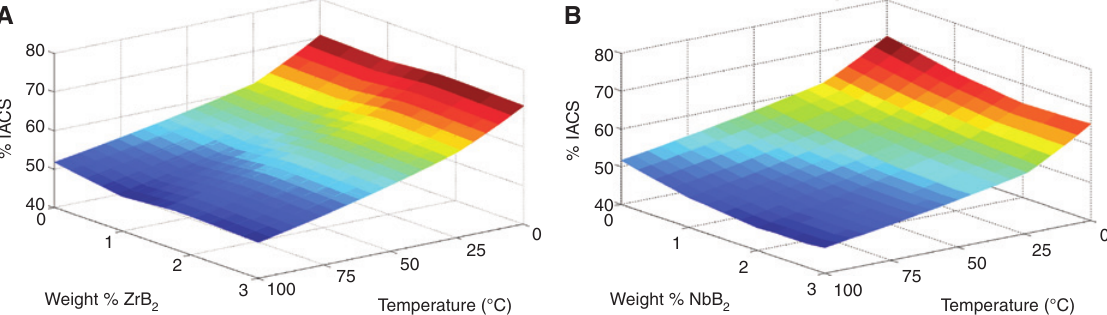
Figure 5 Effect of amounts of diborides added and temperature on the electrical conductivity of aluminum wires (measured as percent of IACS): (A) effect of the ZrB /Al nanocomposite, (B) effect of the ZrB 2